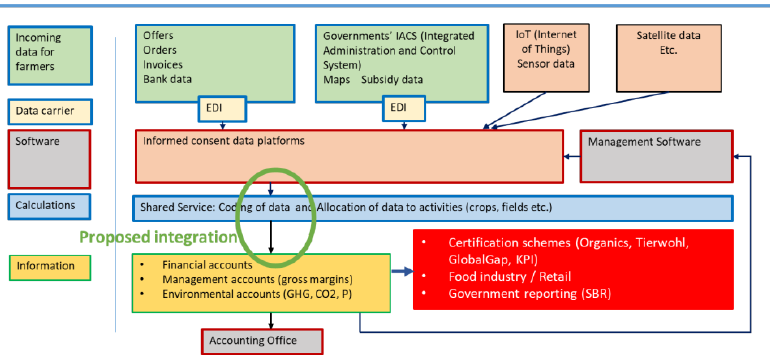
Figure 6. Data flows and the place of a Farm Financial Accounting and Farm Management Infor- mation Systems